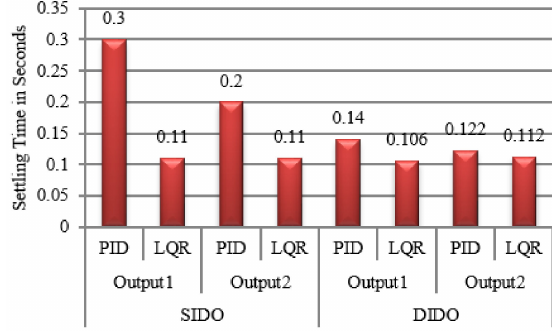
Figure 14. Performance comparison of SIDO and DIDO Converters with LQR and PID controllers.